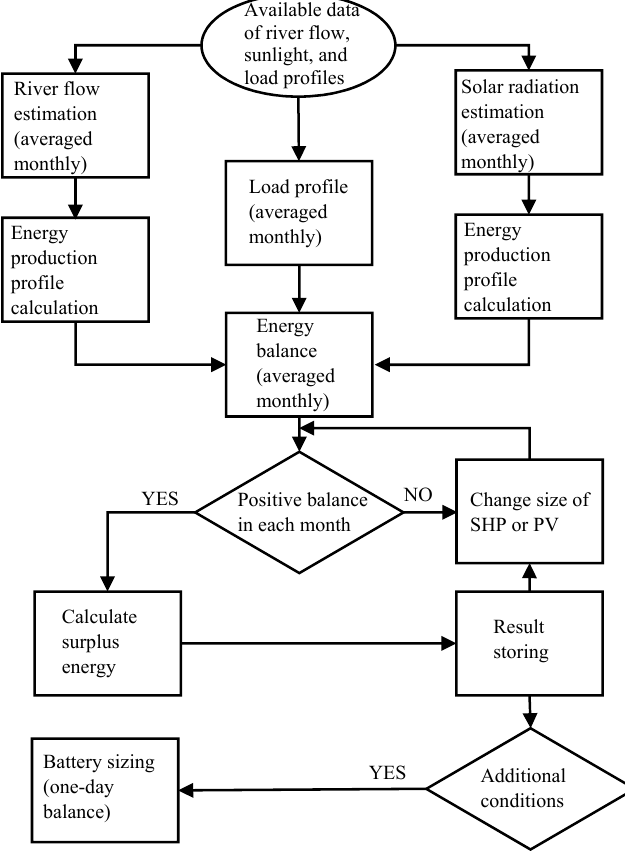
Figure 6. Sizing algorithm of the hydro/PV/battery hybrid system as a local supplier.